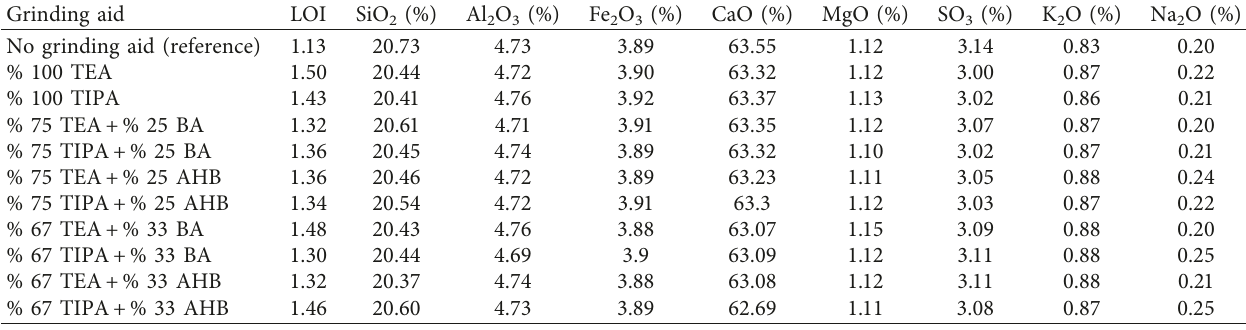
Table 2: XRF elemental analysis of the reference cement and ground cement mixtures with grinding aids and boron compounds. Grinding aid LOI